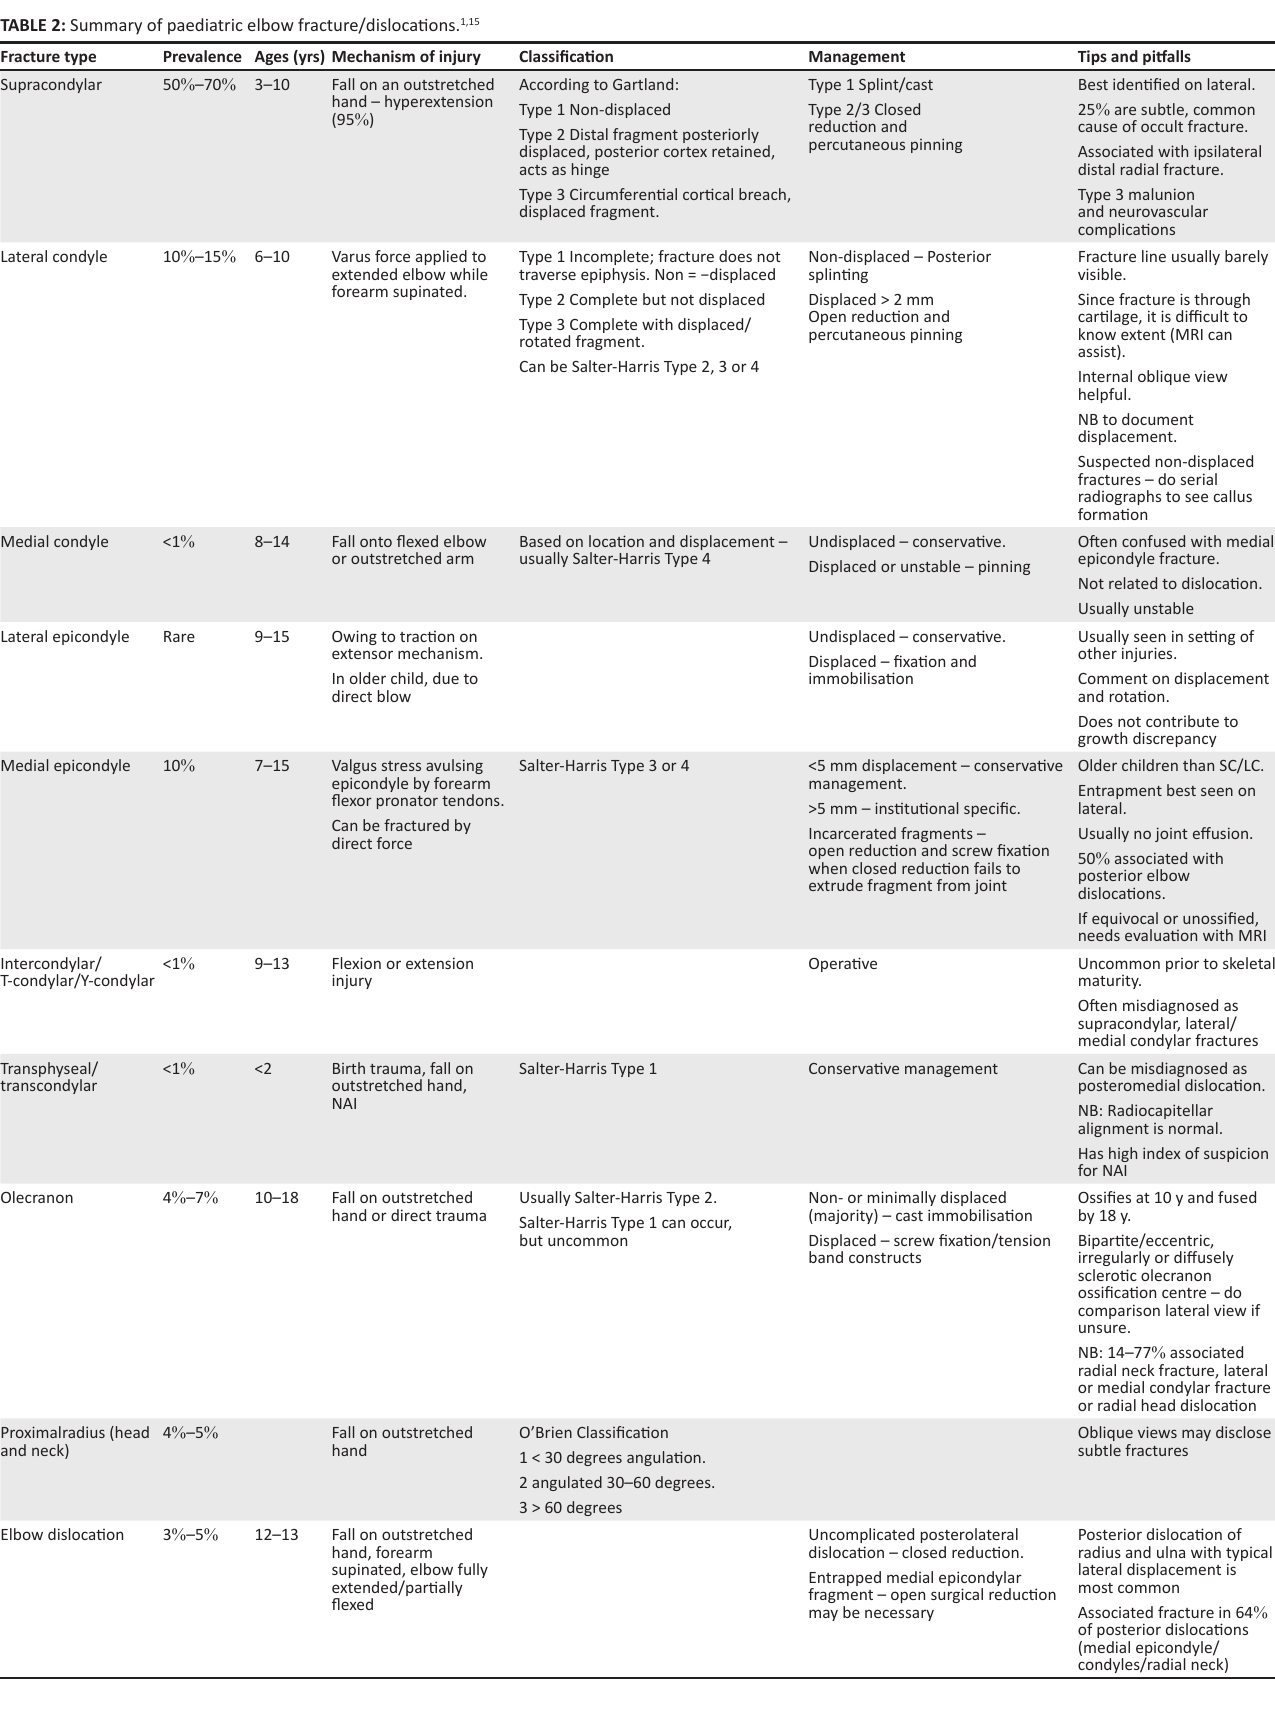
TABLE 2: Summary of paediatric elbow fracture/dislocations. 1,15 Fracture